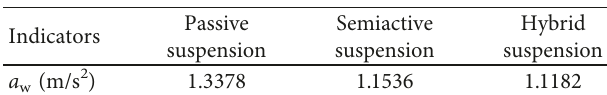
Figure 27: The power spectrums of the sprung mass acceleration of the hybrid suspension in semiactive mode. Table 7: The sprung mass acceleration RMS of the hybrid sus- pension in semiactive